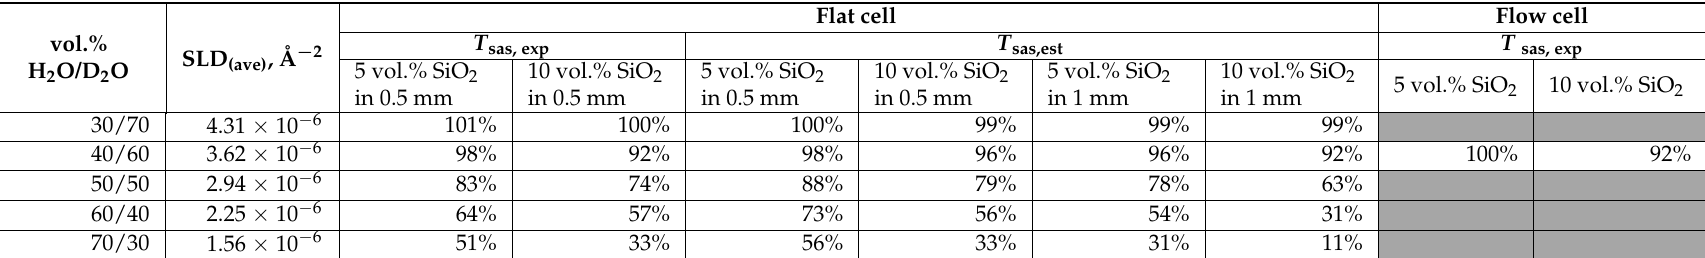
Table 1. Scattering length density (SLD) and T SAS values experimentally determined ( T SAS,exp ) at 5 vol % SiO 2 and 10 vol % SiO 2 at pH 10 with 0.5 mm path length, respectively. Also shown are the corresponding calculated values T SAS, est for the thickness of 0.5 mm and 1 mm, using Equation (8) *.